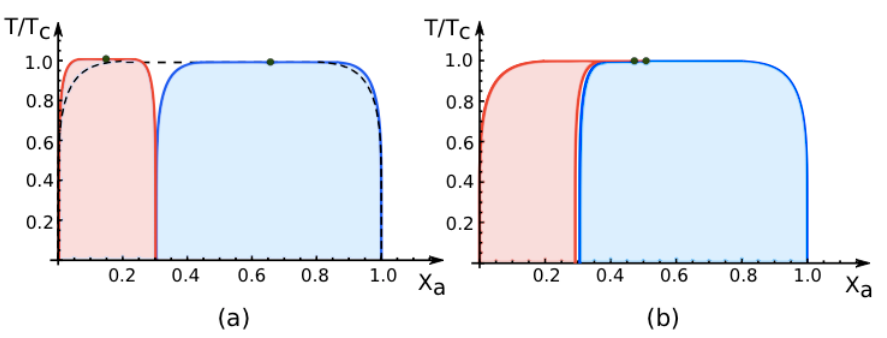
Figure 6. Exact phase diagrams of the lattice model for adhering membranes as a function of area fraction X a and reduced temperature T/T c for ( a ) large and ( b ) small negative values of the affinity contrast ∆ U 2 , 1 and fixed area fraction q [1] = 0 . 7 . Negative values of ∆ U 2 , 1 imply that the a -molecules prefer to stay in membrane segment S [2] , corresponding to the bound segments in Figure 2 and Figure 3a as well as to the strongly bound segment in Figure 3b. The blue and red regions again represent the two-phase coexistence regions of the segments S [1] and S [2] , respectively, but, compared to Figures 4 and 5, these two coexistence regions have now swapped their relative